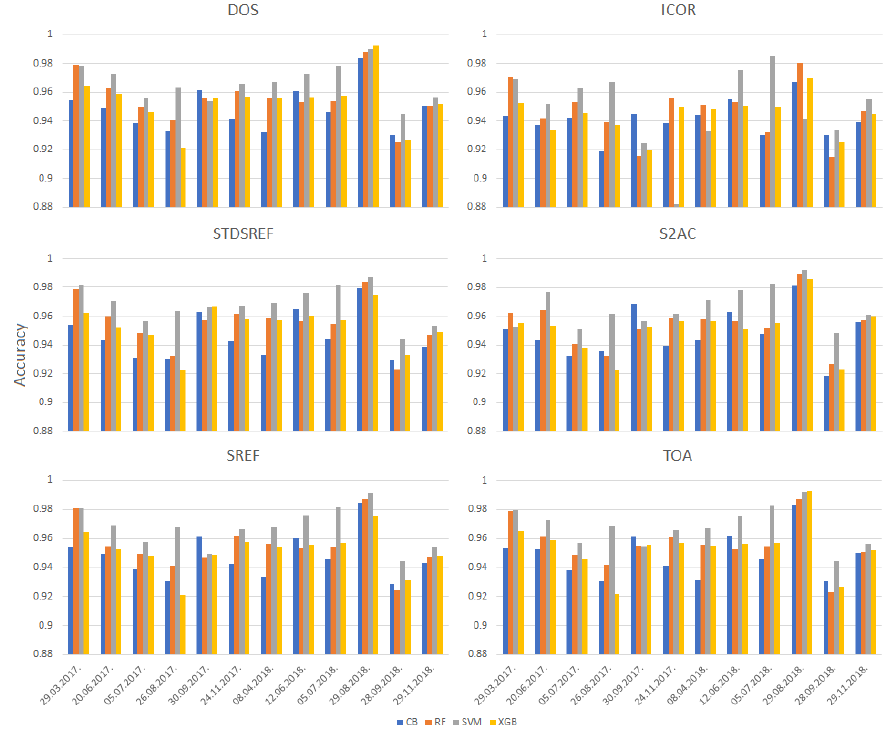
Figure 6. Classification accuracy based on atmospheric correction and date without vegetation indices.